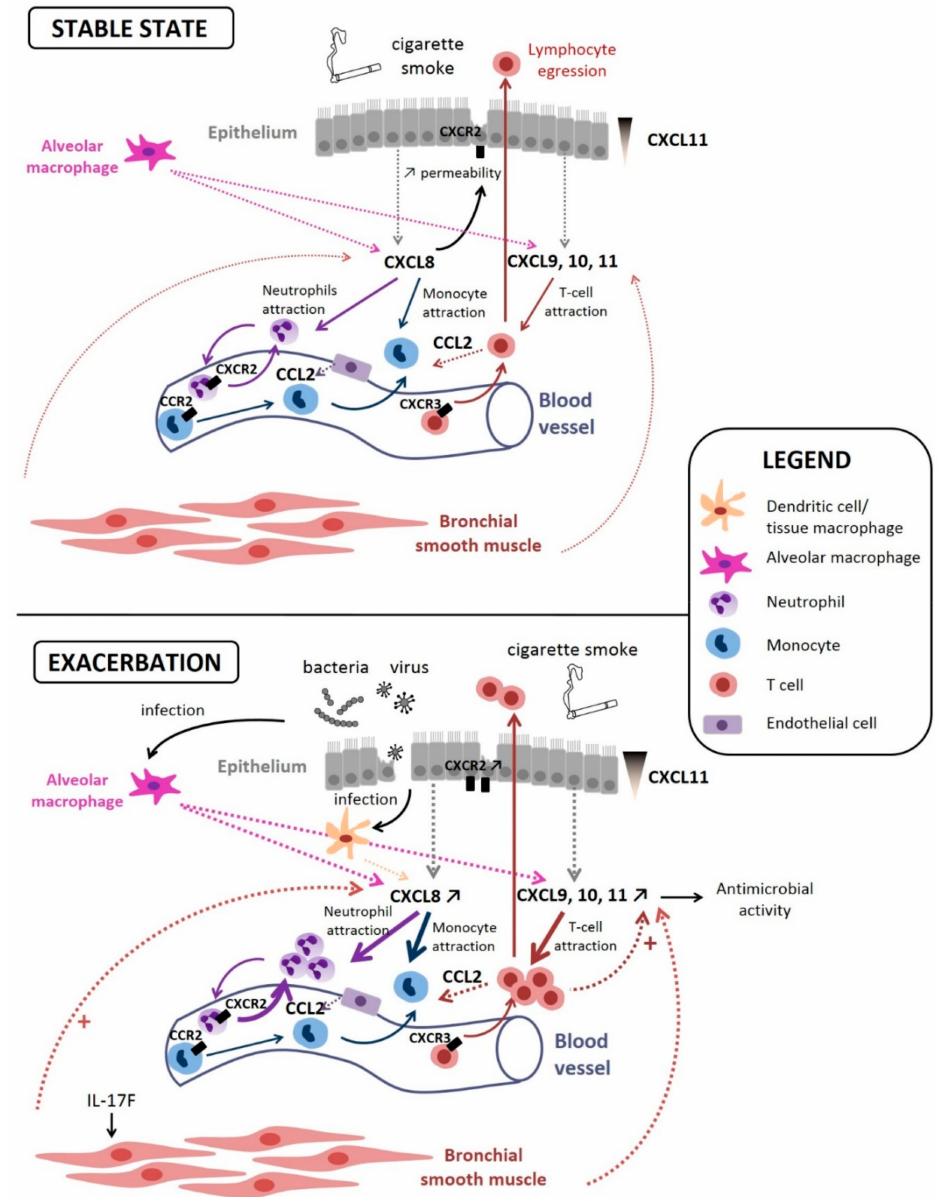
Figure 2. CXCL8-CXCR1 / 2, CXCL9 / 10 / 11-CXCR3, and CCL2-CCR2 axis implications at stable state and during an exacerbation in a COPD lung. At the stable state, CXCL8 (produced by alveolar macrophages, epithelial cells, and bronchial smooth muscle cells) binds on CXCR2 to attract circulating neutrophils and monocytes into the bronchial tissue as well as to increase epithelial cells permeability. CXCL9, 10, and 11 (produced by alveolar macrophages, epithelial cells, and bronchial smooth muscle cells) bind on CXCR3 to attract circulating T cells. A CXCL11 intra-epithelial gradient is responsible for lymphocyte egression towards the lumen. CCL2 (produced by T cells and endothelial cells) binds on CCR2 to attract monocytes. During an exacerbation, production of CXCL8 as well as CXCL9, 10 and 11 is enhanced, which increases the recruitment of monocytes and T cells into the bronchial tissue, participating to the immune (often triggered by microbial infection) response. Chemokines production by bronchial smooth muscle cells can be further enhanced upon IL-17F stimulation. The plain arrows (without other indications) show cell movements; the dotted arrows indicate chemokine secretion. Overall, cellular crosstalk between alveolar macrophages and epithelial-secreted CXCL8 and CXCR2-expressing neutrophils contributes to COPD